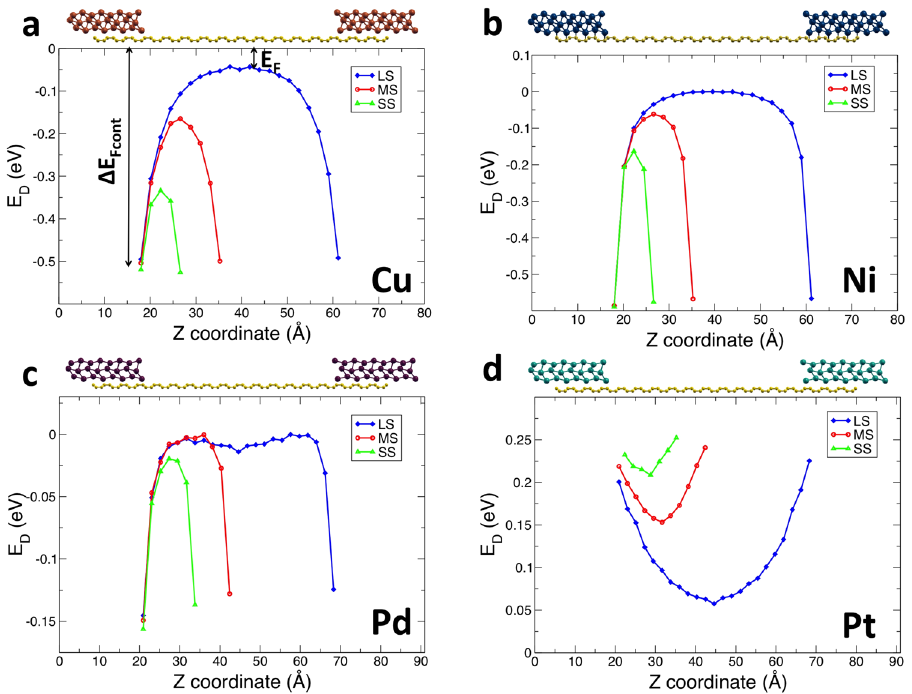
Figure 4. Dirac point energy profile. Profile of the Dirac point energy E D ( z ) as along the transport direction for all the considered metals and for different distances between the metal islands (long structure (LS), medium structure (MS), short structure (SS)). A picture of the long structure is shown at the top of each picture. In all cases the Fermi Energy is taken as zero.